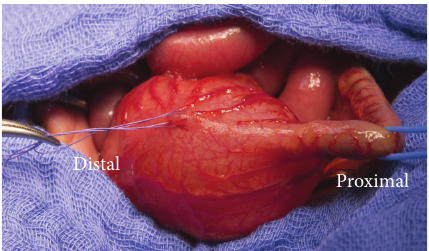
Figure 2: Macroscopic presentation at surgery with normal proxi- mal colon (vessel loop) ending in a pouch measuring approximately 6 × 4.5 × 2